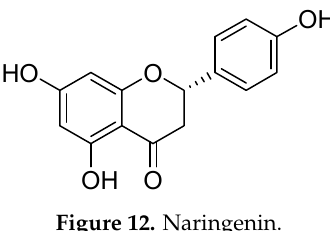
Figure 12. Figure 12. Naringenin.